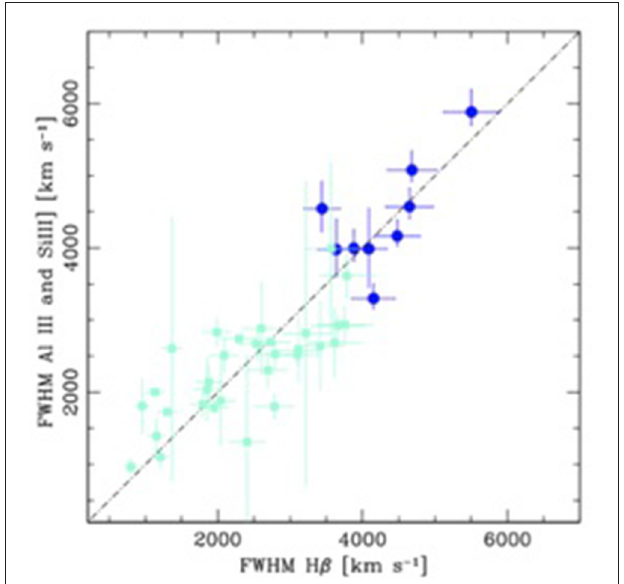
FIGURE 2 | FWHM of Al III λ 1860 vs. FWHM H β in km s − 1 for Pop. A sources. The pale blue dots represent quasars from the RQ Pop. A sample of Sulentic et al. (2007) , while the blue are from the high-luminosity sample of Sulentic et al. (2017) . The dot-dashed line traces the 1:1